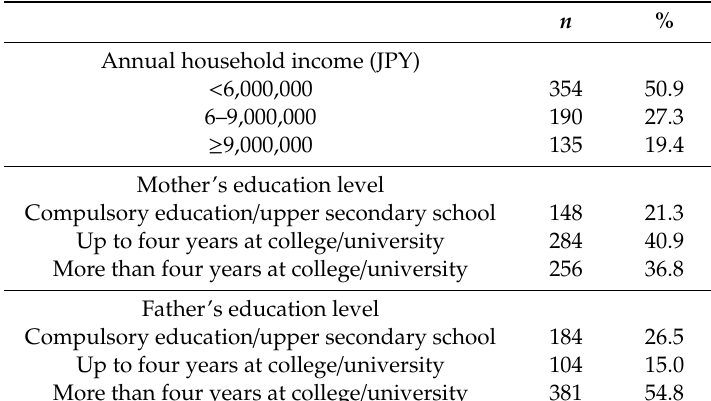
Table 2. Socioeconomic status of participants ( n =